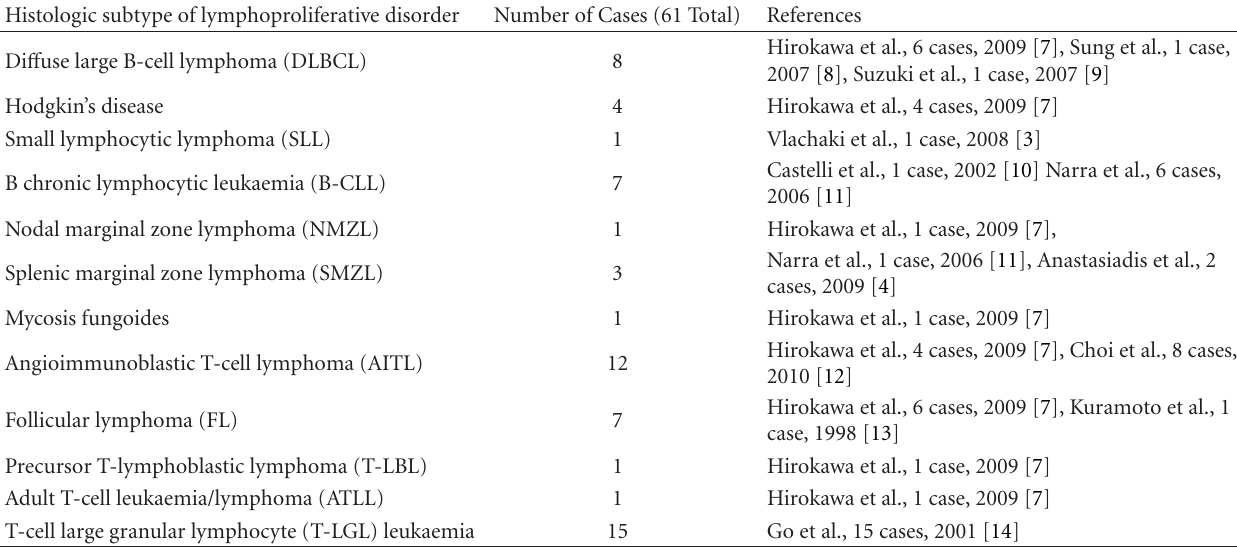
Table 2: Histologic subtypes of lymphoid malignancies in association with PRCA [3, 4, 7–14]. Literature review was performed in references [4, 7, 11, 12] and the additional cases have been added to the